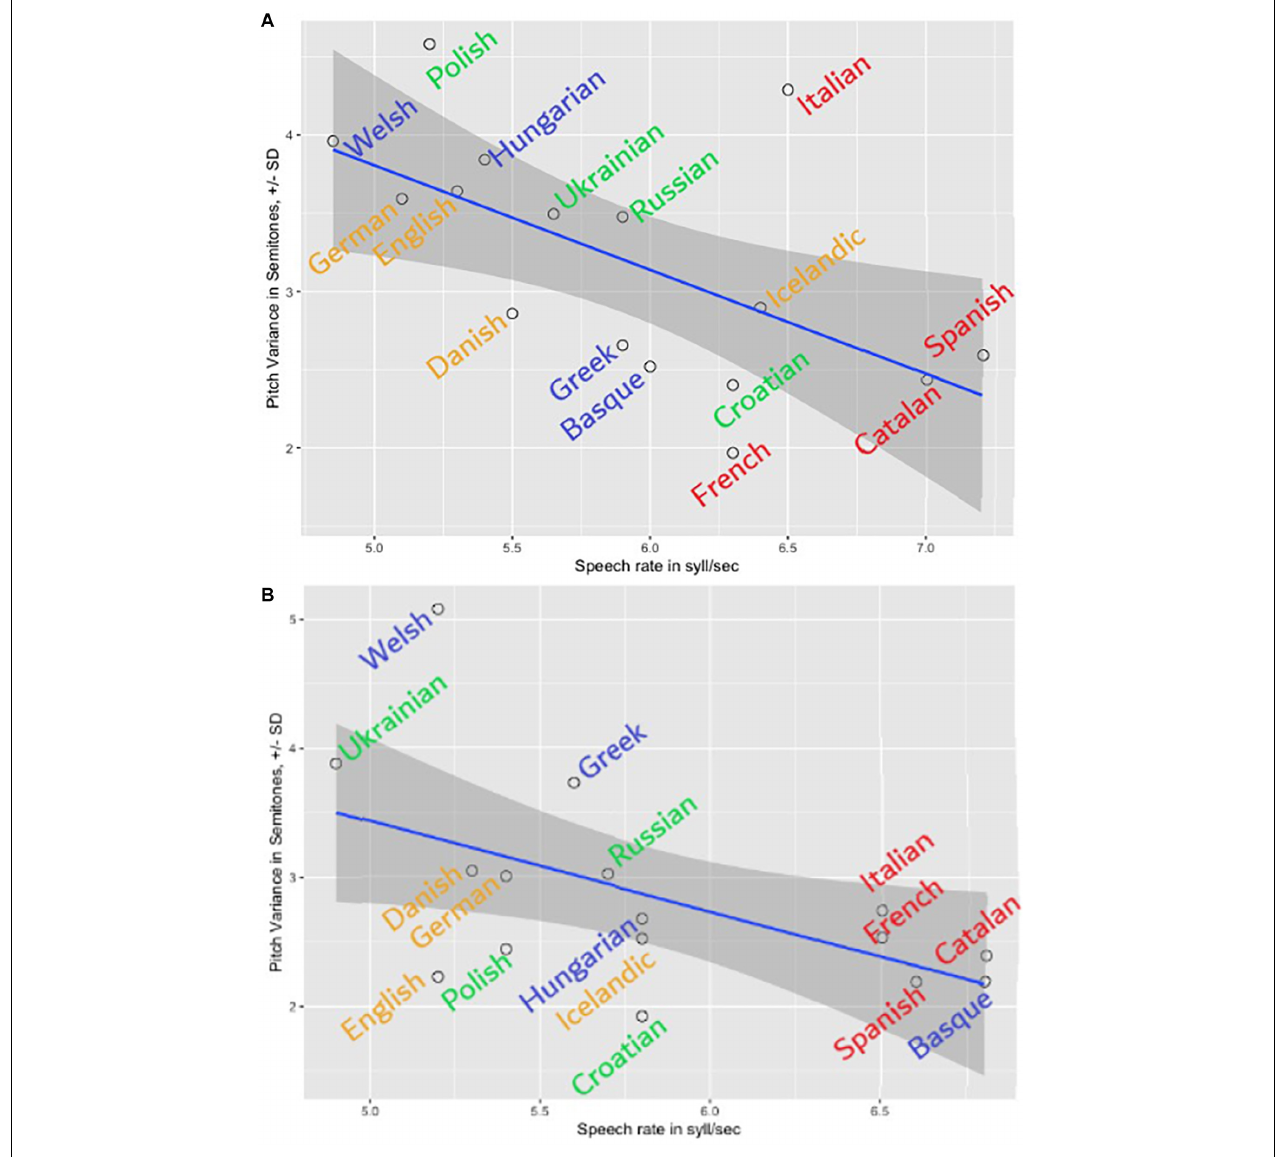
FIGURE 7 | The speed-melody trade-off in the first (A) and the second (B) sets of language recordings: the slower the speech, the more pitch modulations are found.